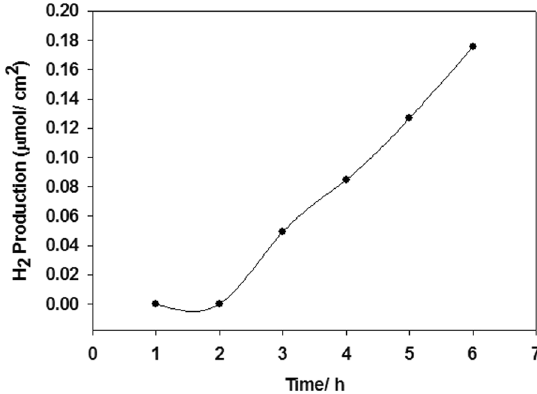
Figure 8. Hydrogen evolution test of LaFeO 3 in an aqueous 0.1 M